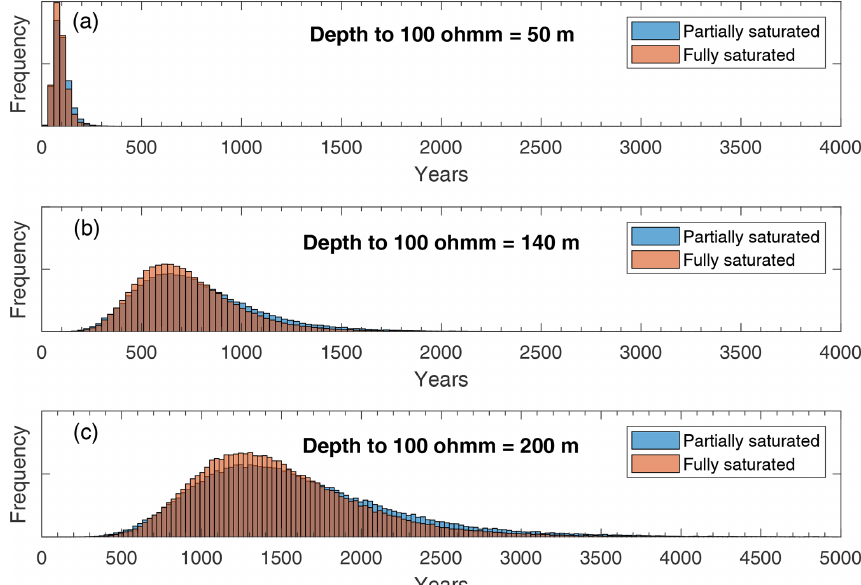
Figure 12. Age estimates from Monte Carlo analysis as discrete depth to 100 (cid:127) m brine–permafrost boundary. Each panel shows Monte Carlo analysis results for partially saturated (blue) and fully saturated (orange) conditions at three discrete depths to brine. The shallowest depth to brine ( a , 50m) shows how age of permafrost is relatively well constrained. Thicker depths to brine ( b , 140m or c , 200m) show how increasing depth to brine also results in less constrained ages of permafrost. A partially saturated substrate (blue bars) results in slightly older permafrost ages compared to a fully saturated (orange bar) substrate.